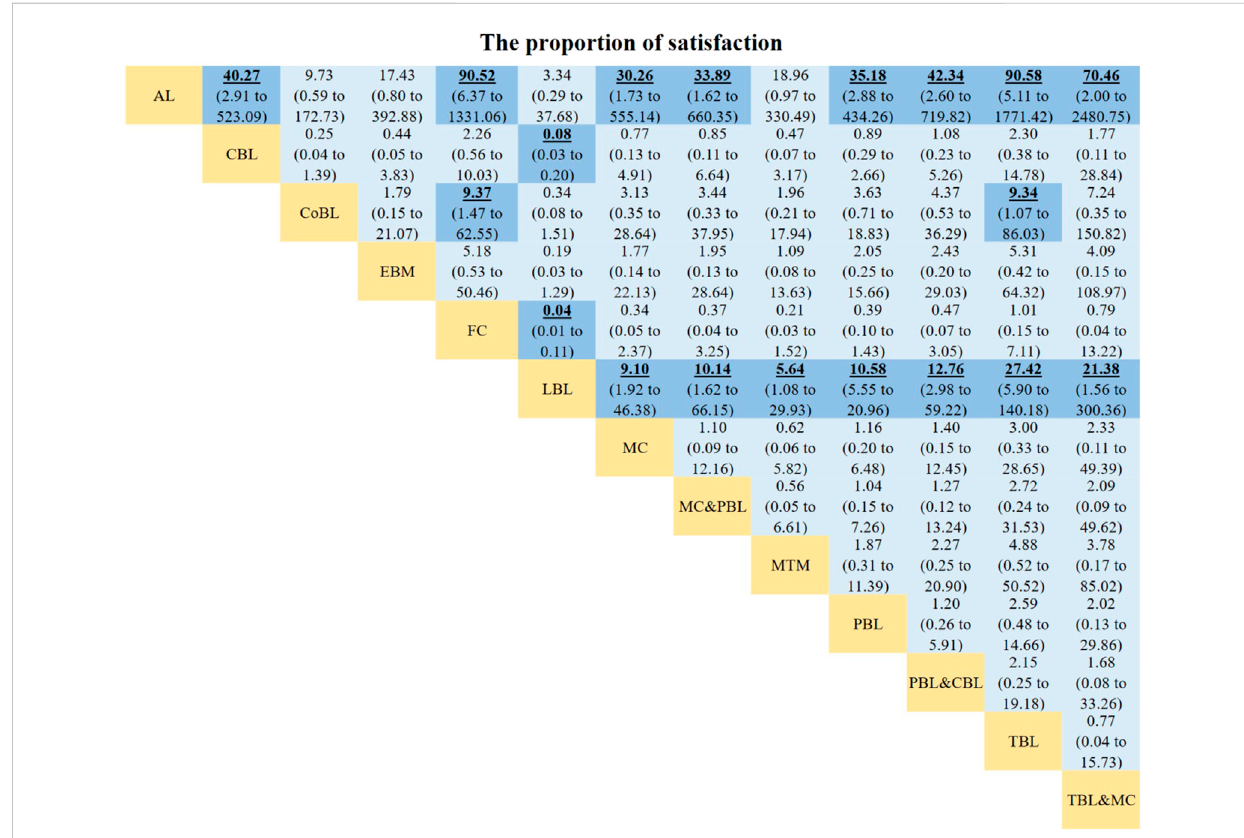
FIGURE 6 Odds ratios of the proportion of satisfaction. Data with odds ratios represent the comparison of row-de fi ning method versus column-de fi ning method. Data in parentheses are the 95% credible intervals. Odds ratios more than one favour the column-de fi ning method. Signi fi cant results are highlighted in bold, underline, and background fi ll. NR represents this indicator was not reported in this method among the included